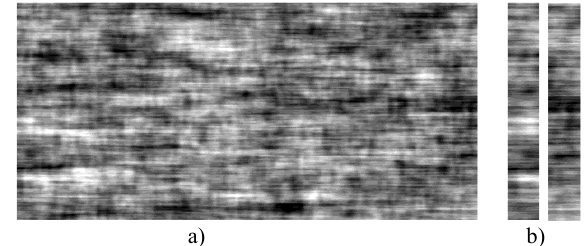
Figure 2. Simulated images: a) image simulated by Habibi